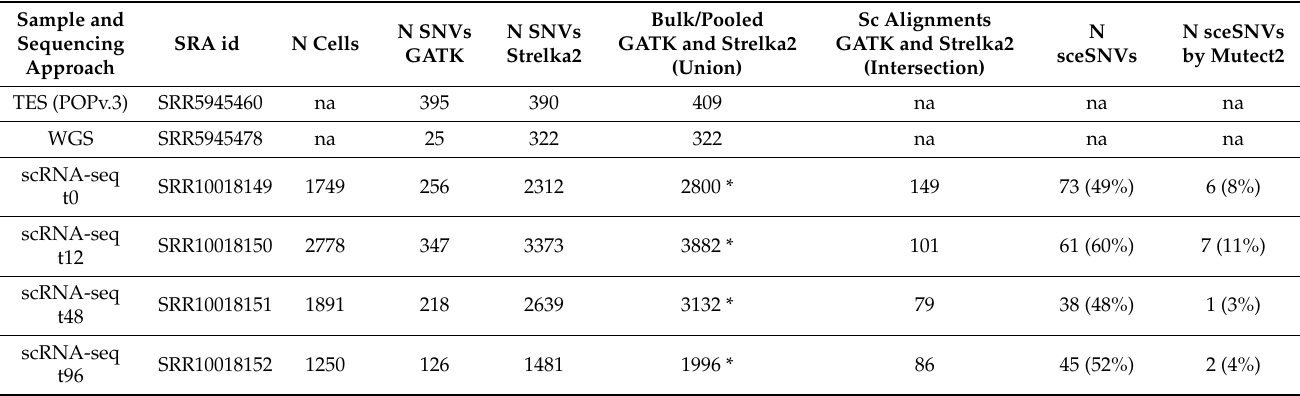
Figure 1. Analytical workflow for the identification of confident SNVs calls exclusively in the individual scRNA-seq alignments. The raw sequencing reads were aligned to GRCh38, using BWA for the DNA and STARsolo for the RNA data. GATK and Strelka were applied in parallel on both the pooled and individual scRNA-seq alignments. For the pooled/bulk data, all SNVs called by either GATK or Strelka2 SNVs were retained; for the individual alignments, the SNVs that were called confidently by both GATK and Strelka2 in each cell were retained. Single-cell exclusive SNVs (sceSNVs) were then outlined via overlapping the union of GATK and Strelka2 calls from the pooled/bulk scRNA and DNA, and the intersection of the GATK and Strelka2 calls from each individual alignment. To assess what percentage of sceSNVs are identifiable with callers specifically targeting SNVs in a low proportion of cells, we applied Mutect2 on the pooled alignments. Table 1. Number of SNVs identified in the MCF7 sequencing datasets, in the exonic regions of the genes included in the ProfileOncoPanel